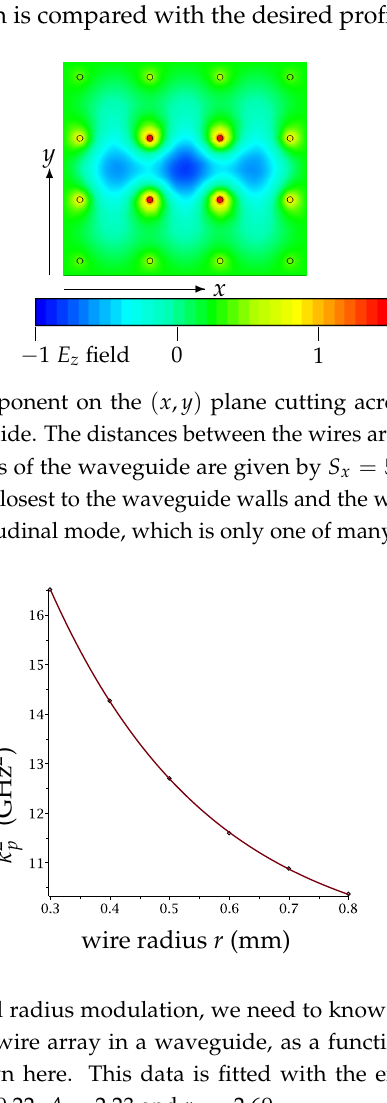
Figure 6. To design the required radius modulation, we need to know the variation of the effective plasma frequency of our 4 × 4 wire array in a waveguide, as a function of wire radius, which for our chosen parameters is shown here. This data is fitted with the exponential function k 2 p ( r ) = y 0 + A exp ( − r / r 0 ) , where y 0 = 9.22, A = 2.23 and r 0 =